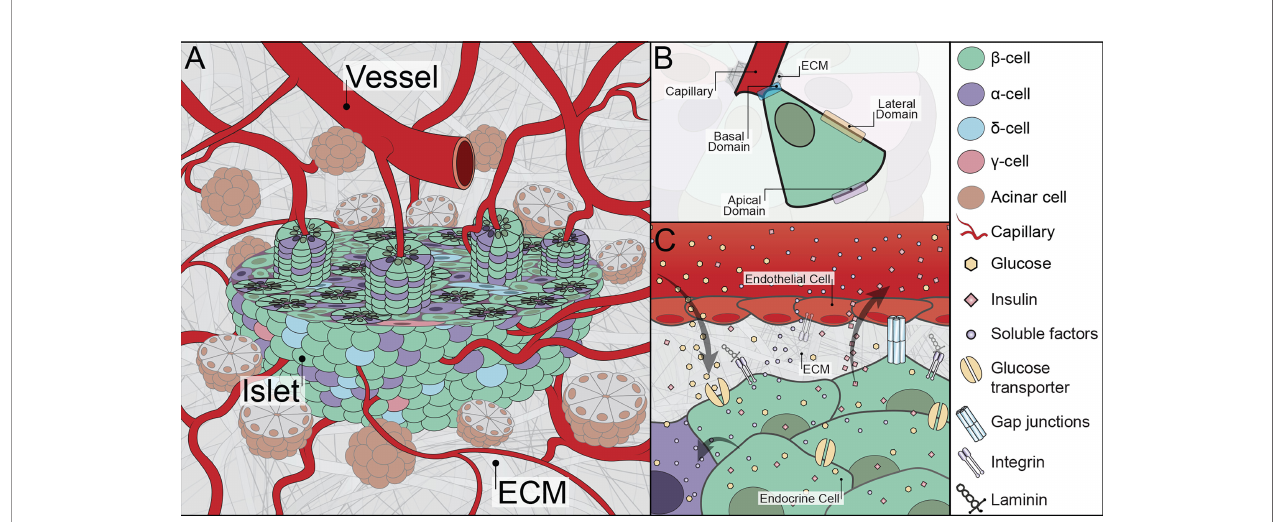
FIGURE 1 | Graphical illustration of relevant islet physiology. (A) The native peri-islet space consists of acinar cell clusters surrounding the pancreatic islets. The islets have an afferent blood vessel adjacent to their structure that quickly converts into tortuous capillary systems. A cross-section of an islet highlights the rosette-like architecture composed of endocrine cells wrapped around a capillary. The interstitial space adjacent to the islets also consists of ECM. (B) Intra-islet architectural organization in a rosette-like structure where distinct faces of an endocrine cell with respect to the capillary are visualized. (C) The subcellular interface of islets showing relevant molecules and cell-cell and cell-matrix interactions. Illustration not drawn to